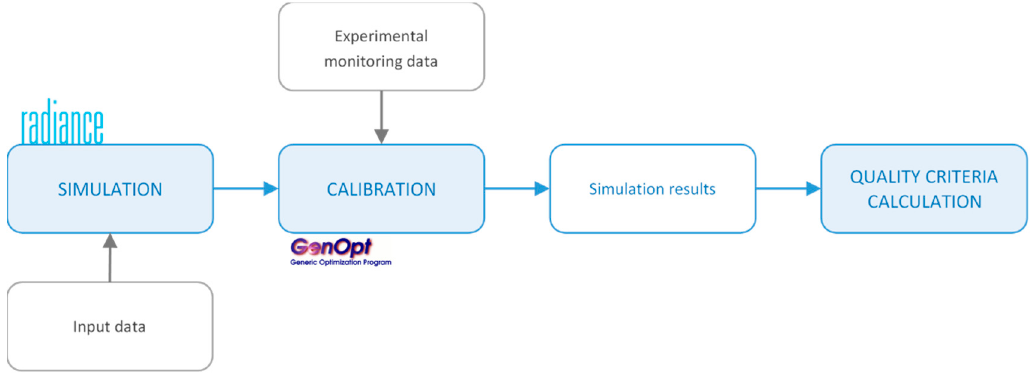
Figure 1. Simulation and calibration methodology diagram.